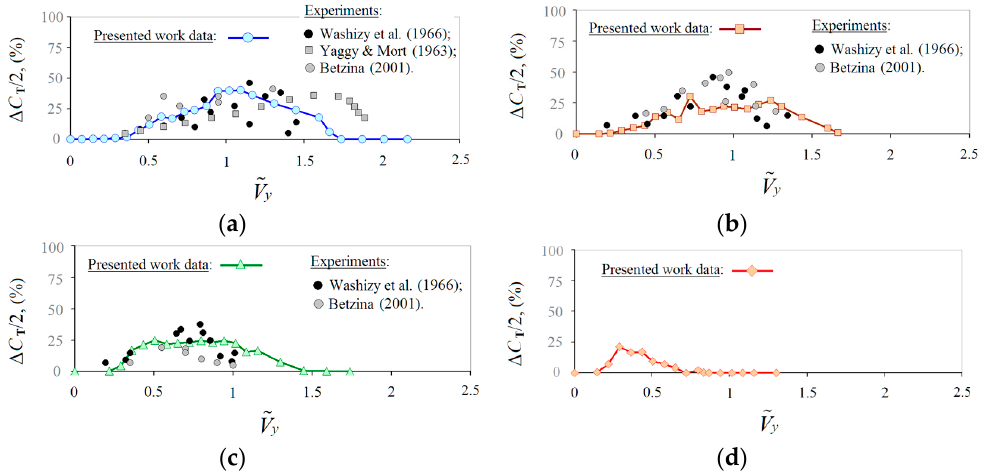
Figure 15. Calculated and experimental [11,12,14] dependencies of thrust pulsation amplitude Δ C ТΣ /2 = f( 𝑉(cid:3560) (cid:3052) ) at α R = 90 ‒ 30°. ( a ) α R = 90°; ( b ) α R = 70°; ( c ) α R = 50°; ( d ) α R =